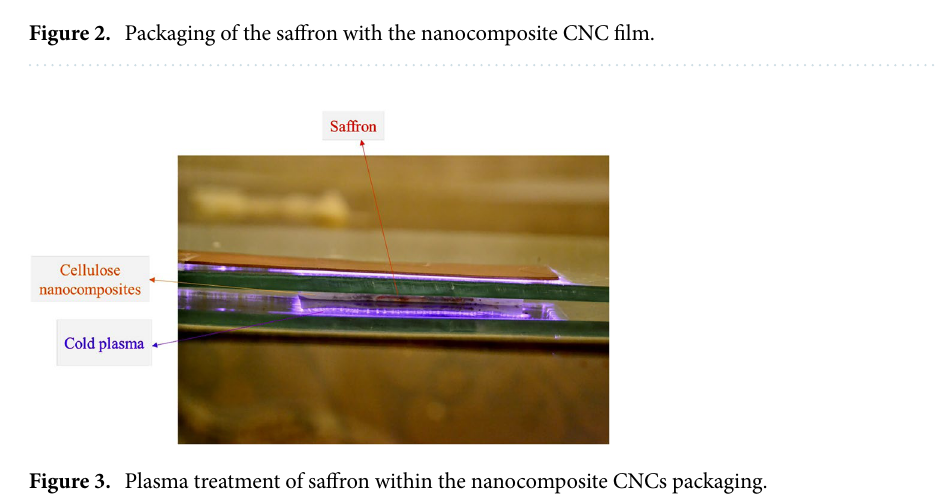
Figure 3. Plasma treatment of saffron within the nanocomposite CNCs